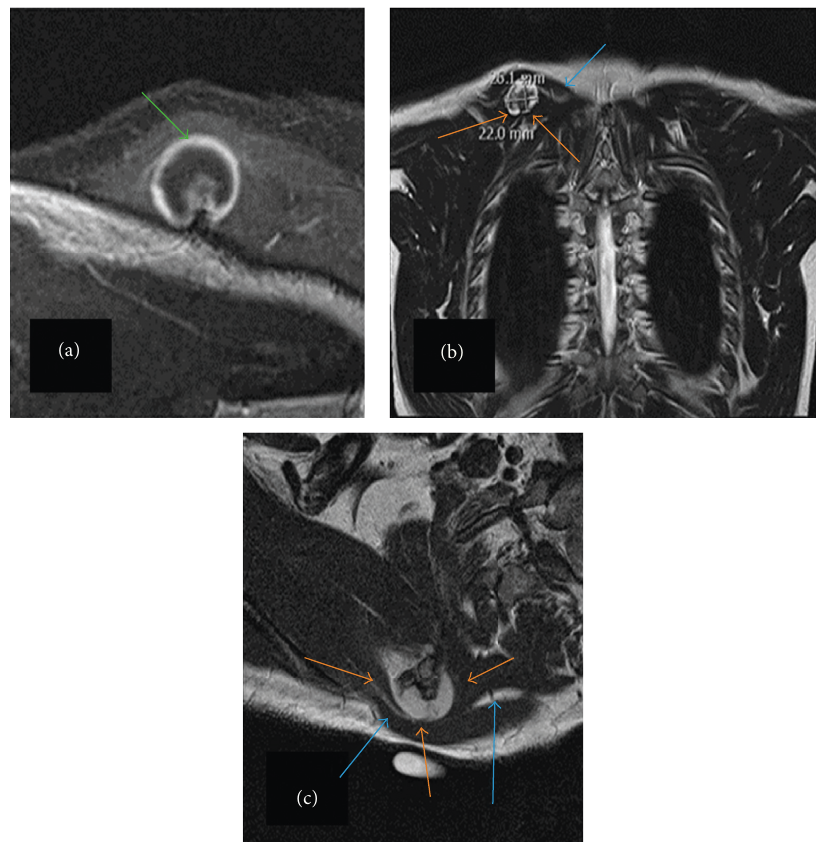
Figure 3: Thoracic MR imaging of the osteochondroma. T1 axial view (a) illustrating the benign 9 mm smooth cap (green arrow). T2 coronal (b) and sagittal (c) views showing the osteochondroma measuring 2.6cm T × 2.6cm AP × 2.2cm CC (orange arrows) located on the right scapula and compressing the accessory nerve (blue